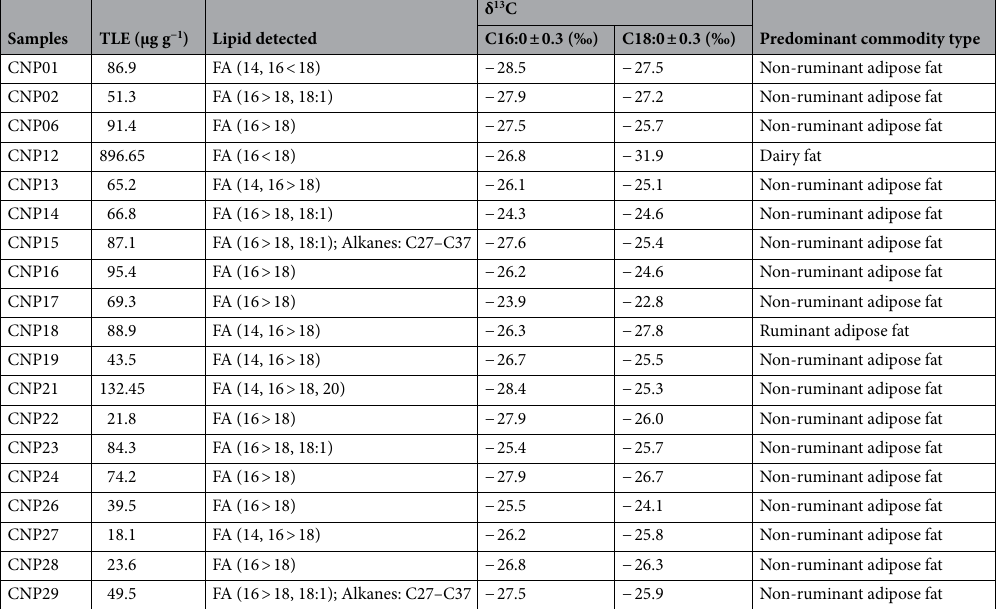
Table 1. Organic residues analysis from Cabecicos Negros results. FA fatty acids, TLE total lipid extract.